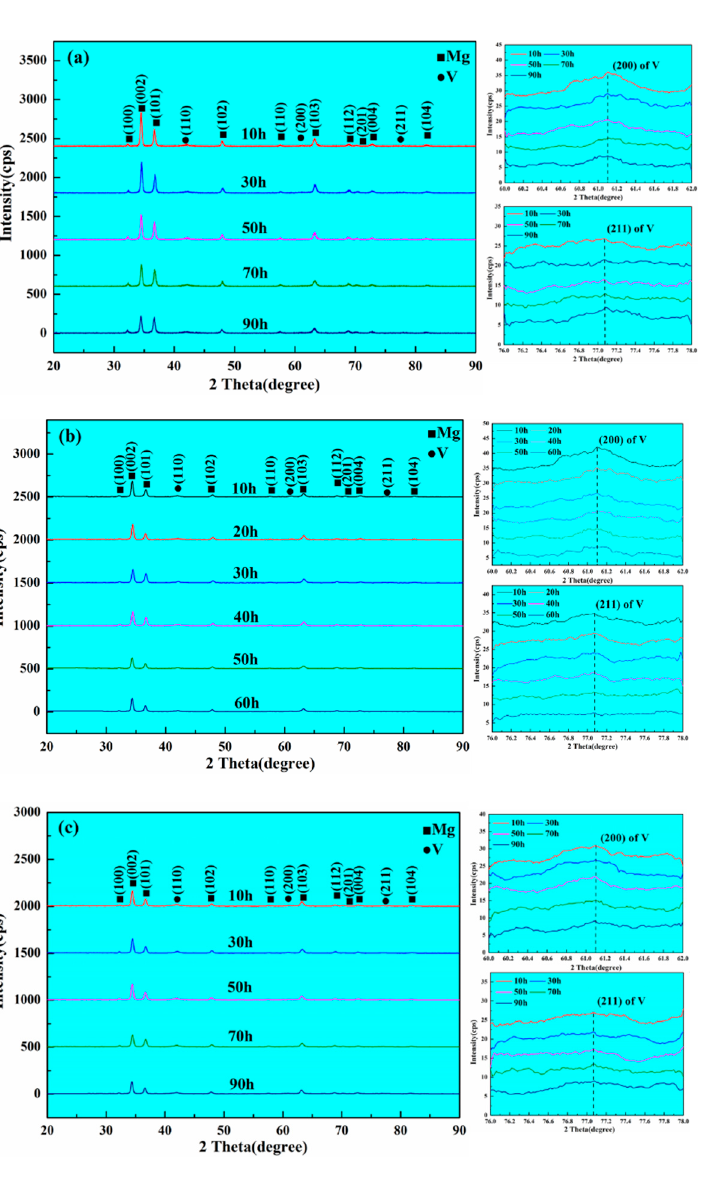
Figure 5. The XRD patterns of AZ31–V P powders with different V P contents after different milling